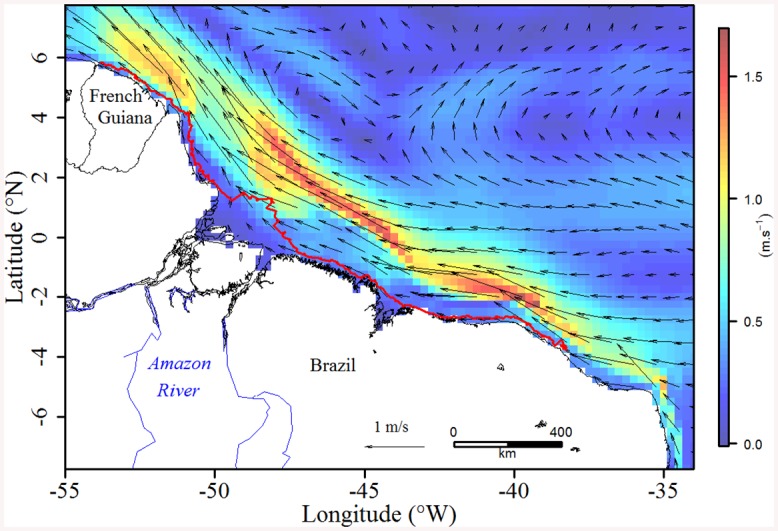
Mean direction and velocity of the currents over the whole study area for the 2012 and 2014 tracking periods extracted daily from Mercator-Ocean GLORYS-2v1 (Global Ocean ReanalYsis and Simulations). The trajectory of turtle #115452 (red) is superimposed on the current.For a better visual representation, the spatial resolution of the current direction is set to 0.75 degrees. The shoreline was extracted from NOAA National Geophysical Data Center, Coastline.